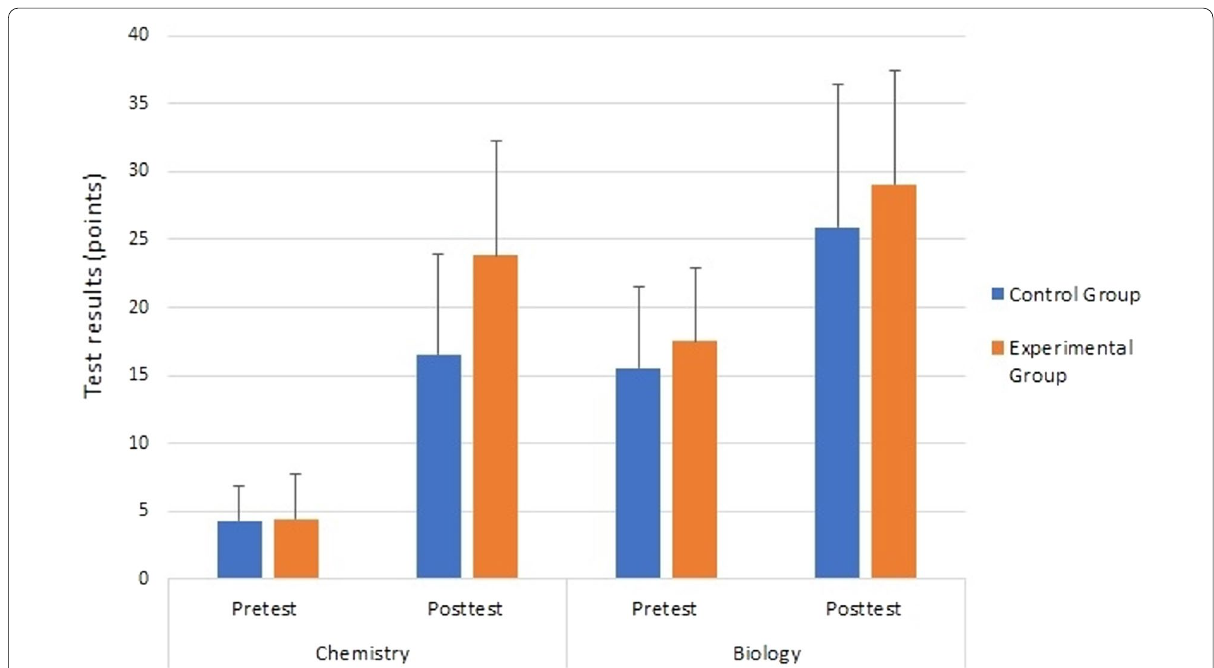
Fig. 4 Results from the knowledge tests in CG and